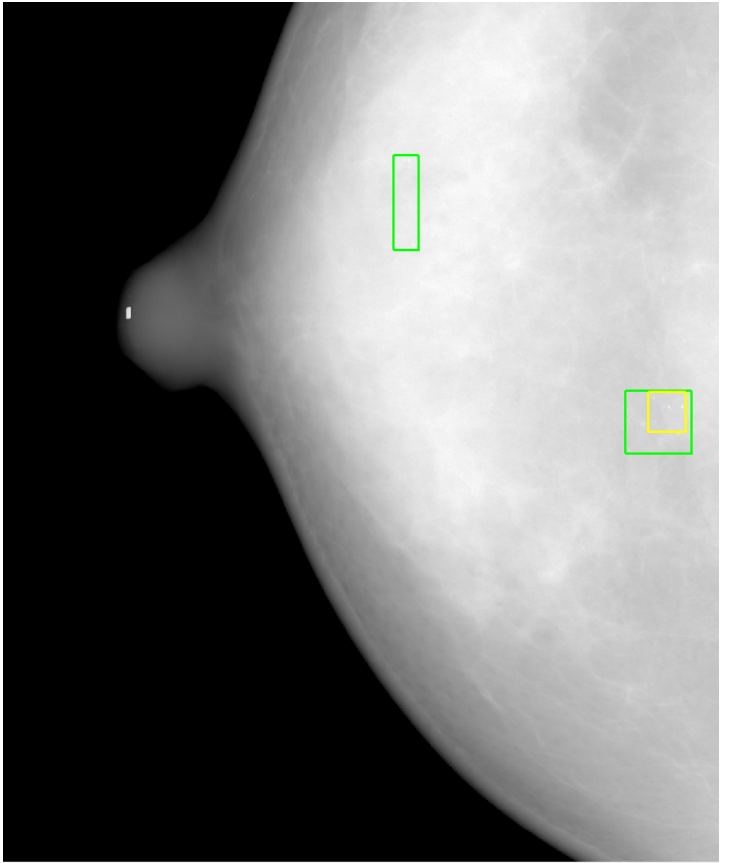
Figure 12. Examples of a false positive (lower rectangle) and a false negative (upper